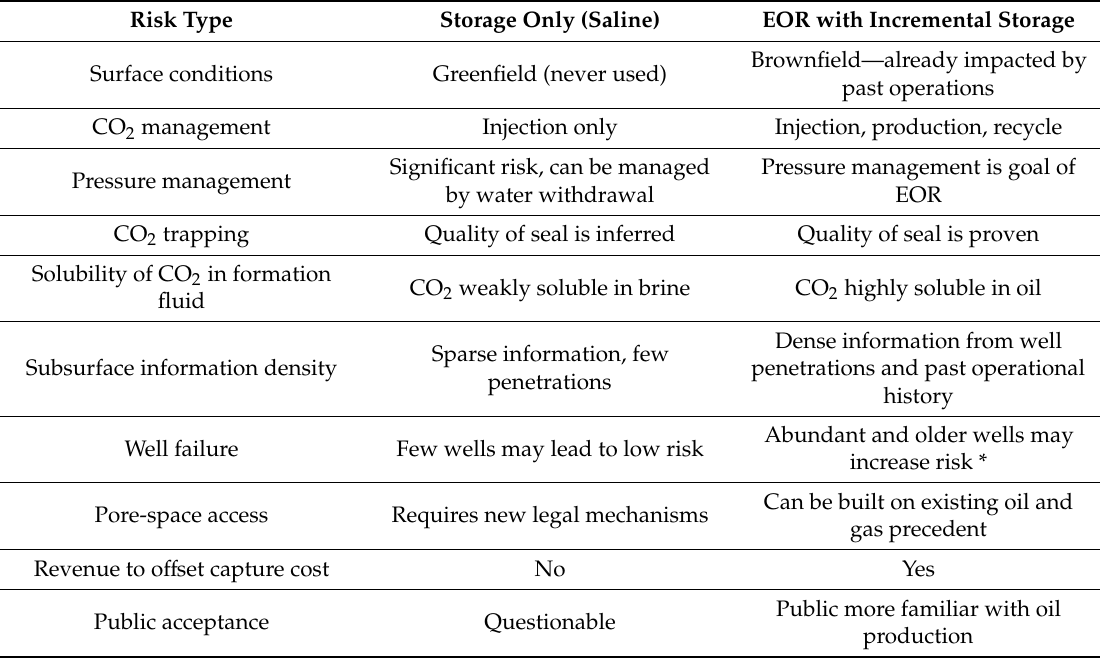
Table 4. Comparative risks for CO 2 -EOR and storage of CO 2 . Adapted from Reference